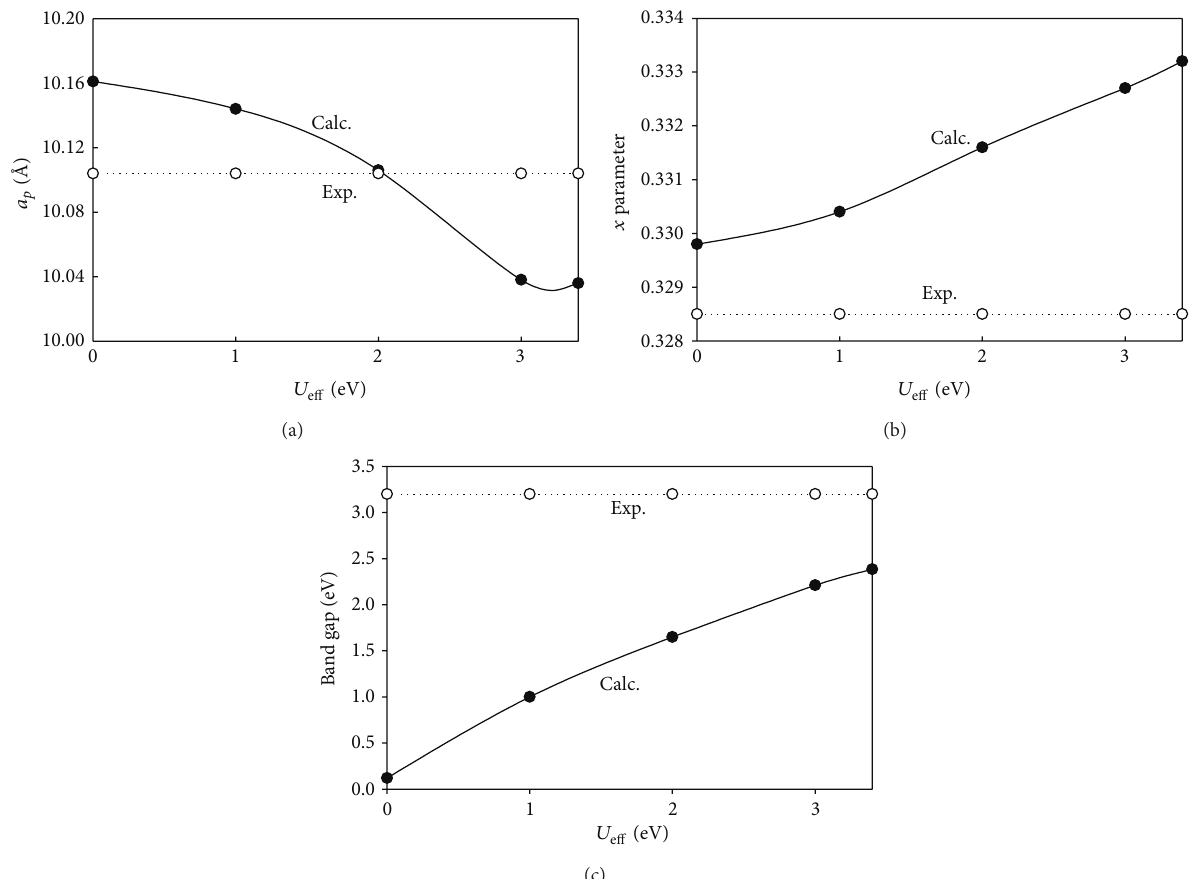
Figure 3: Dependence of the lattice parameter 𝑎 𝑝 (a), 𝑥 (b), and band gap (c) of the Ho 2 Ti 2 O 7 on 𝑈